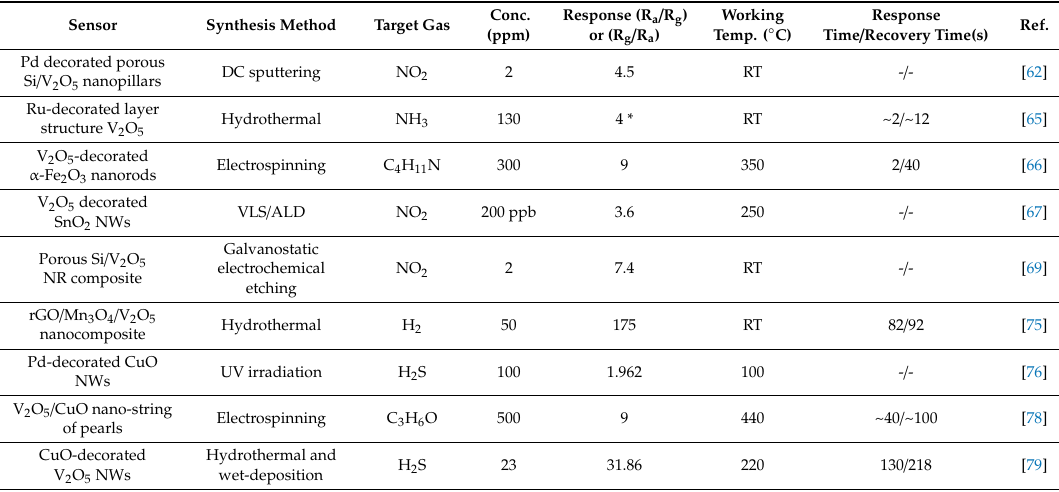
Table 2. Gas sensing properties of decorated or doped V 2 O 5 -based gas sensors.